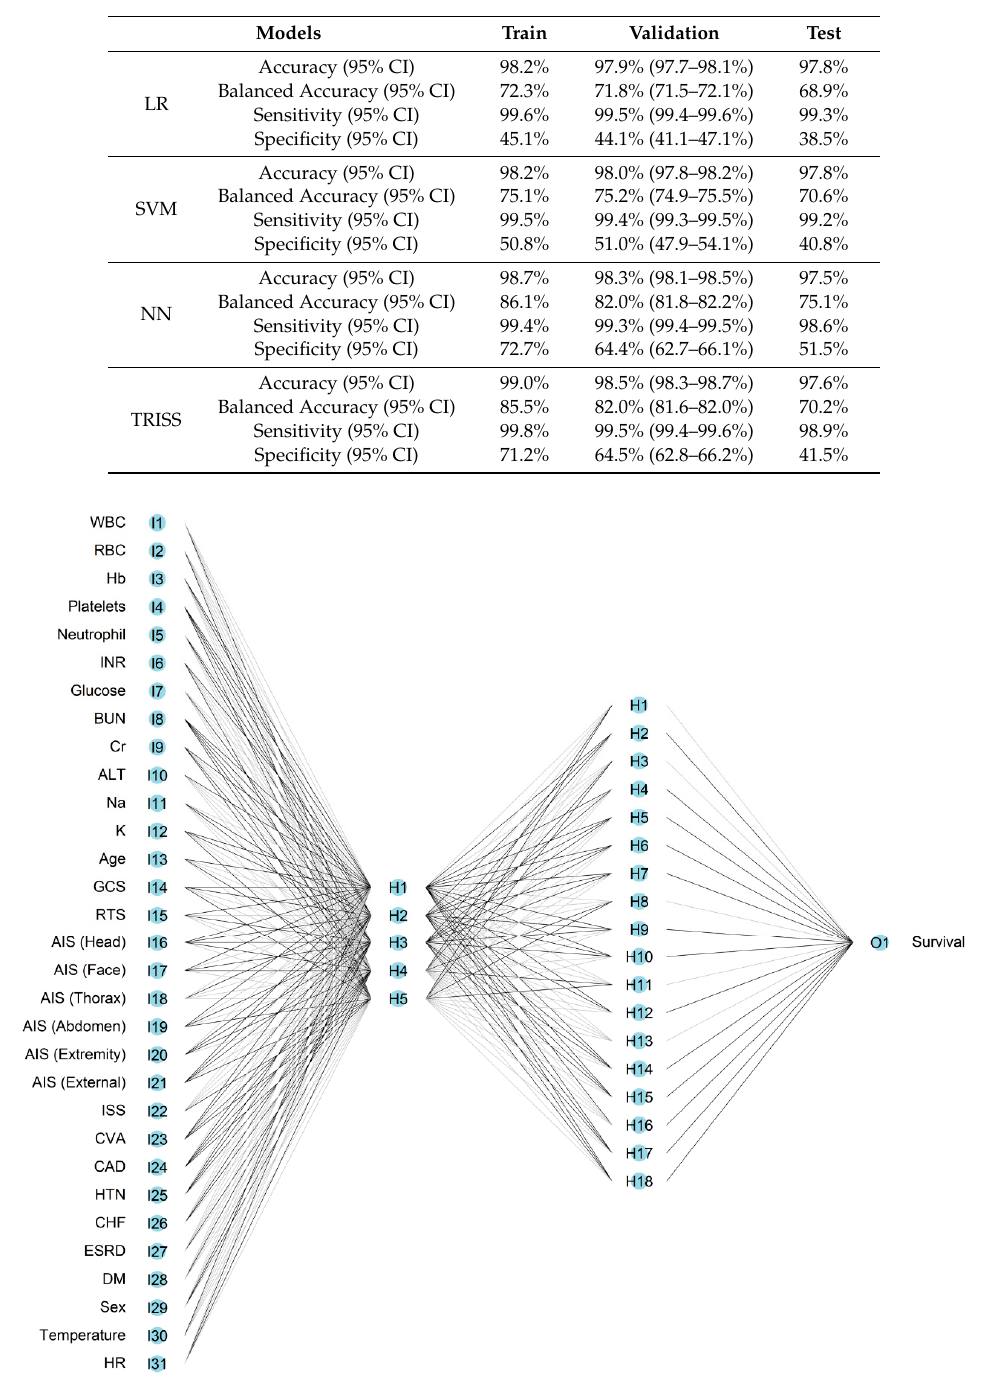
Table 3. Survival prediction performance (i.e., accuracy, sensitivity, and specificity) for the logistic regression (LR), support vector machine (SVM), neural network (NN), and The Trauma and Injury Severity Score (TRISS) models in the train, validation, and test datasets.